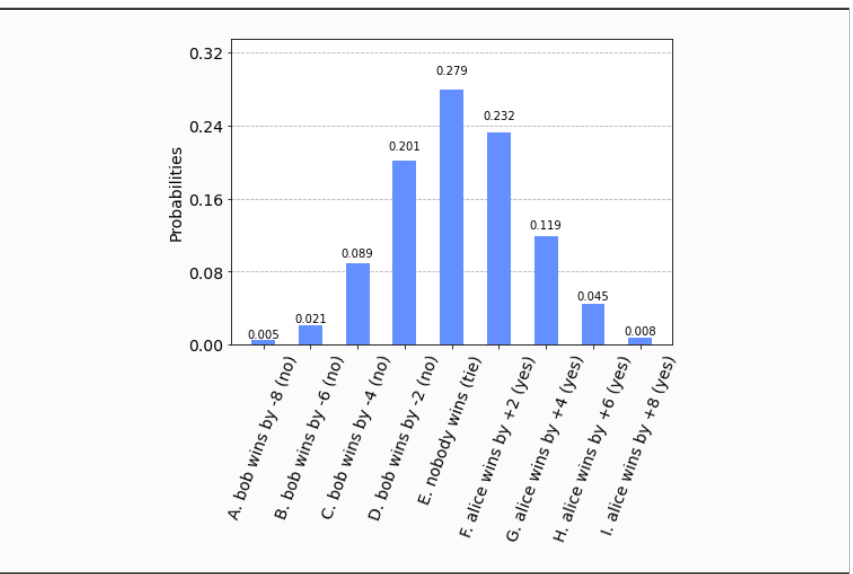
Figure 8. The possible outcomes and their probabilities when r A = r B = 0.7.